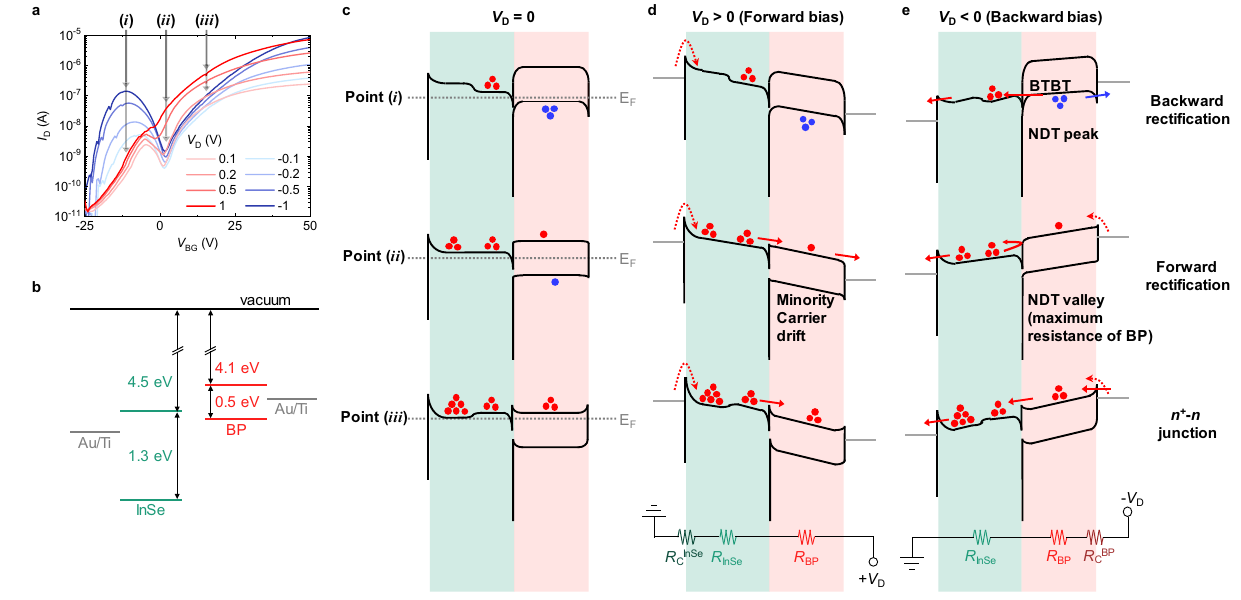
Figure 3. ( a ) I D versus V BG of the InSe-BP-Ti device at different V D values. Characteristic points (i), (ii), and (iii) are marked. ( b ) Schematic showing the band parameters and alignment between the InSe, BP, and both Au/Ti contacts. Previously reported Schottky barrier heights of the Au/Ti contacts for the InSe and BP, rather than metal work functions, are marked 43,44 . ( c–e ) Band diagrams of the InSe-BP-Ti device at points (i), (ii), and (iii) and at ( c ) V D = 0, ( d ) V D > 0, and ( e ) V D < 0. Red dots represent electrons, and blue dots represent holes. Corresponding equivalent circuits are illustrated in ( d,e